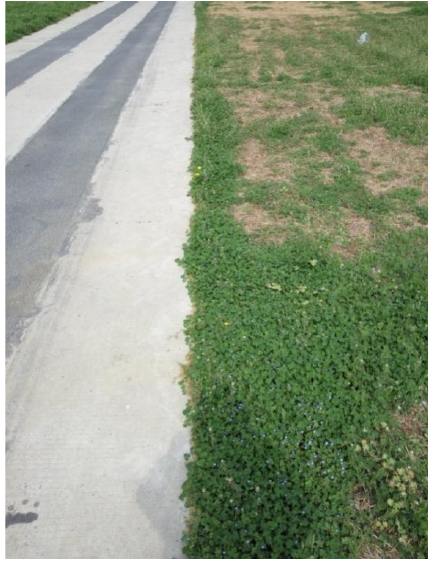
Figure 16. Test of separated road.